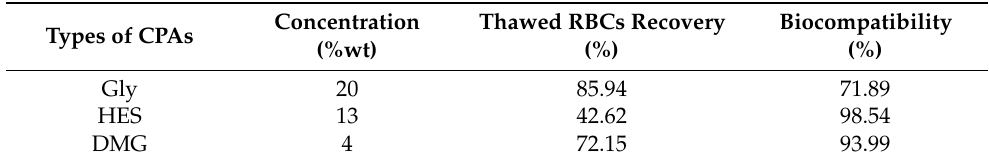
Table 1. Three alternative CPAs and three criteria.